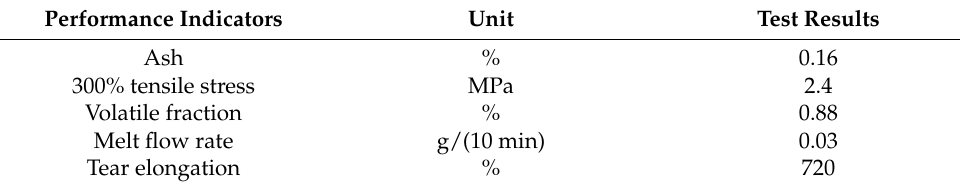
Table 2. SBS Performance Index.